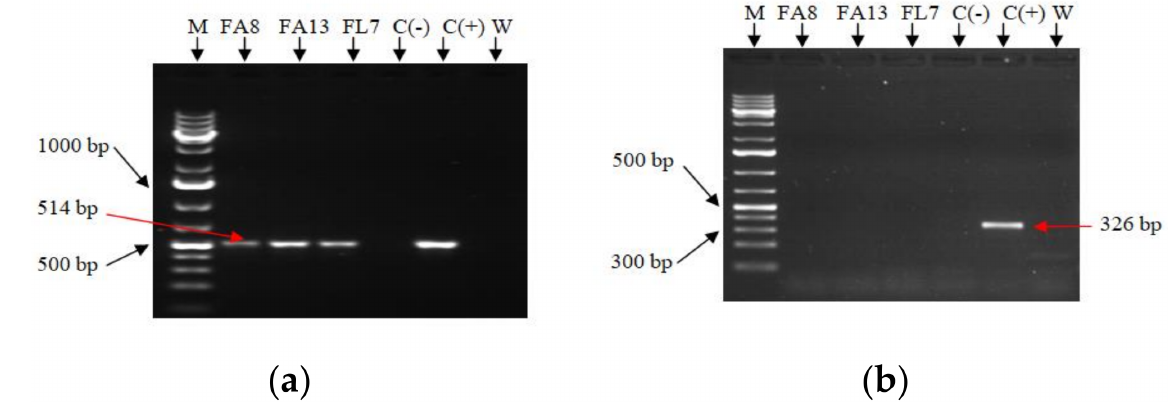
Figure 2. Agarose gel electrophoresis of PCR amplification of genes in putative transformed roots. ( a ) The expected 514 bp rolC fragment; ( b ) the expected 326 bp virC1 fragment. M: marker 1kb plus; FA8, FA13 and FA25: respective clones of hairy root FA8, FA13 and FL7; C( − ): not-transformed root (negative control); C(+): plasmid DNA of A. rhizogenes ATCC 15834 (positive control); W: solution without